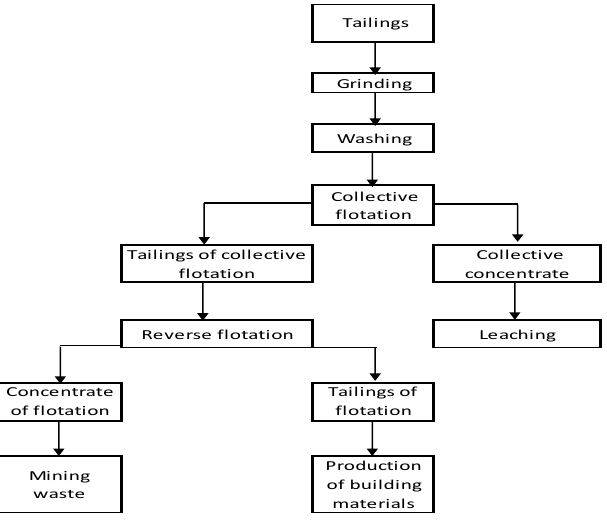
Figure 1. Recommended scheme for processing the old tailings of Pb–Zn ore enrichment. As shown by previous studies of Belousovskaya Enrichment Plant tailings (East Kazakhstan Region) [15], their bulk is represented by a material with a complex chemical composition and a low content of main valuable